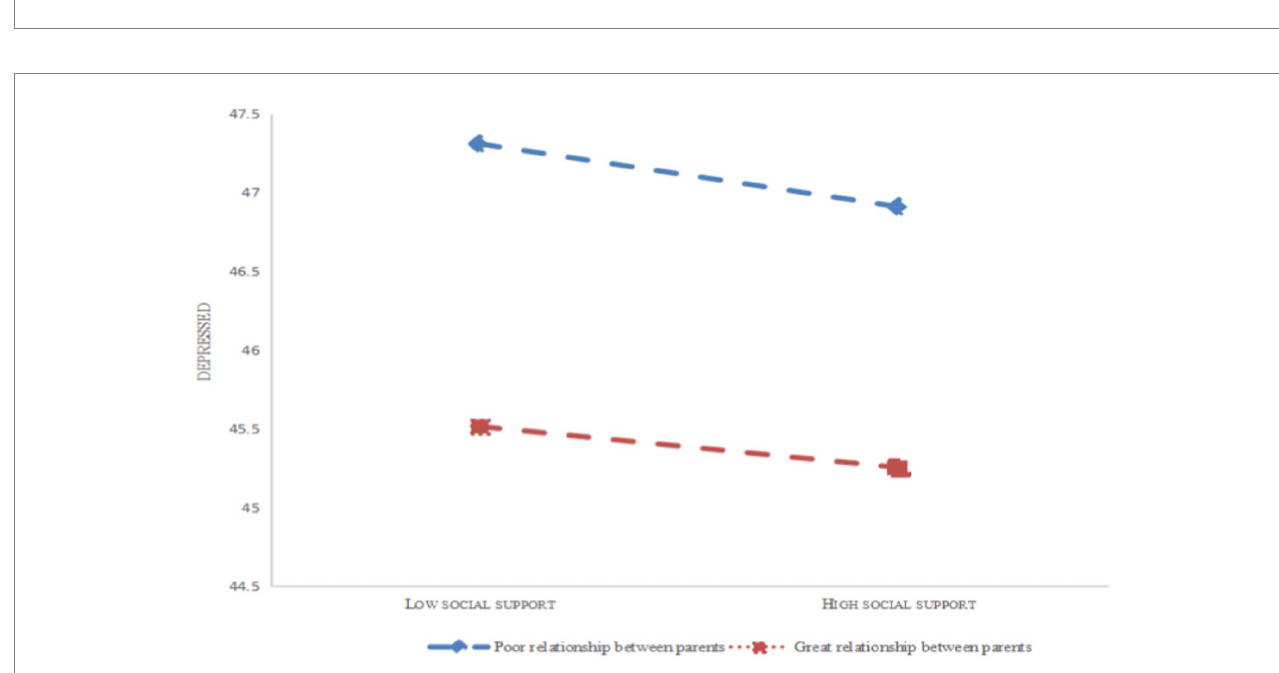
FIGURE 3 The moderating role of the parent–child relationship in social support and coping style.